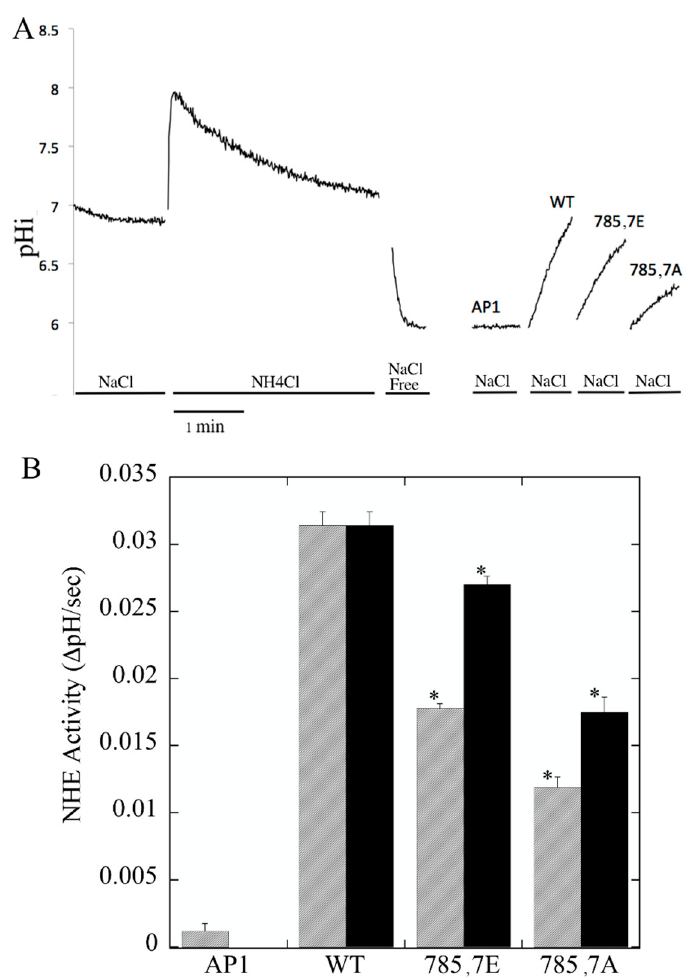
Figure 2. Na + /H + exchanger activity of AP1 cells stably transfected with wild-type (WT) and mutant NHE1 proteins. Na + /H + exchanger activity was measured after ammonium chloride induced acid load as described in Section 4. ( A ) Examples of measurement of Na + /H + exchanger activity. A Trace is shown for one ammonium chloride treatment of cells and the recovery only is shown for one of each kind of cell type. AP1 are cells without the NHE1 protein. ( B ) Summary of activity of NHE1 expressing stable cells lines and AP1 cells. All results are the means ± S.E. of at least six determinations. Results are shown for mean activity of both uncorrected (hatched) and normalized for surface processing and expression levels (solid bars). Asterisks indicate that the value is significantly different than appropriate matched wild-type NHE1 protein at p < 0.001.